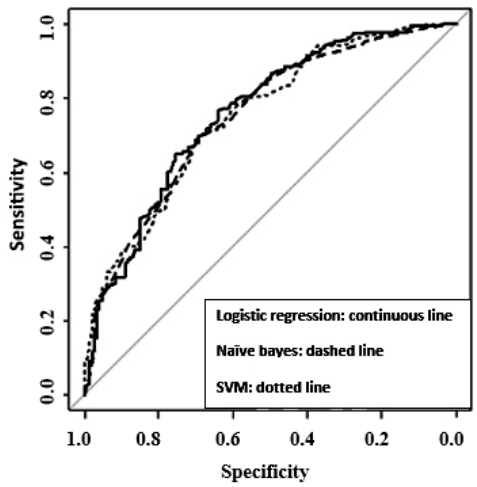
Figure 1. Receiver operating characteristic (Roc) curves for each of the models.